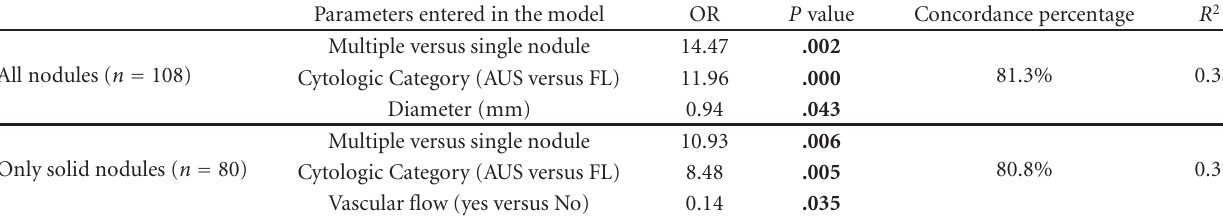
Table 4: Multivariate logistic analysis of the probability of identifying a benign nodule (NH and thyroiditis) versus an adenoma by clinical, echographic features and cytologic